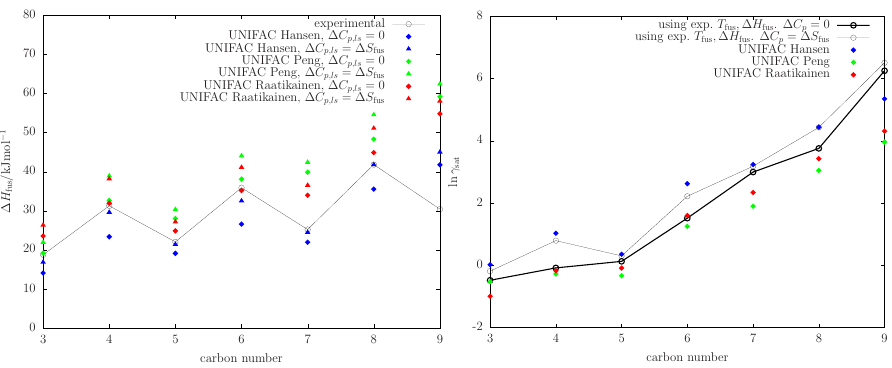
Fig. 3. Left: ∆ H fus for linear diacids (C3-C9), experimental or estimated from experimental T fus ,x sat and estimated γ sat (at 298 K). Right: ln γ sat for the same linear diacids, calculated from experimental T fus , ∆ H fus data and the two limiting assumptions for ∆ C p,ls (0 to ∆ S fus ), or estimated from several UNIFAC methods.